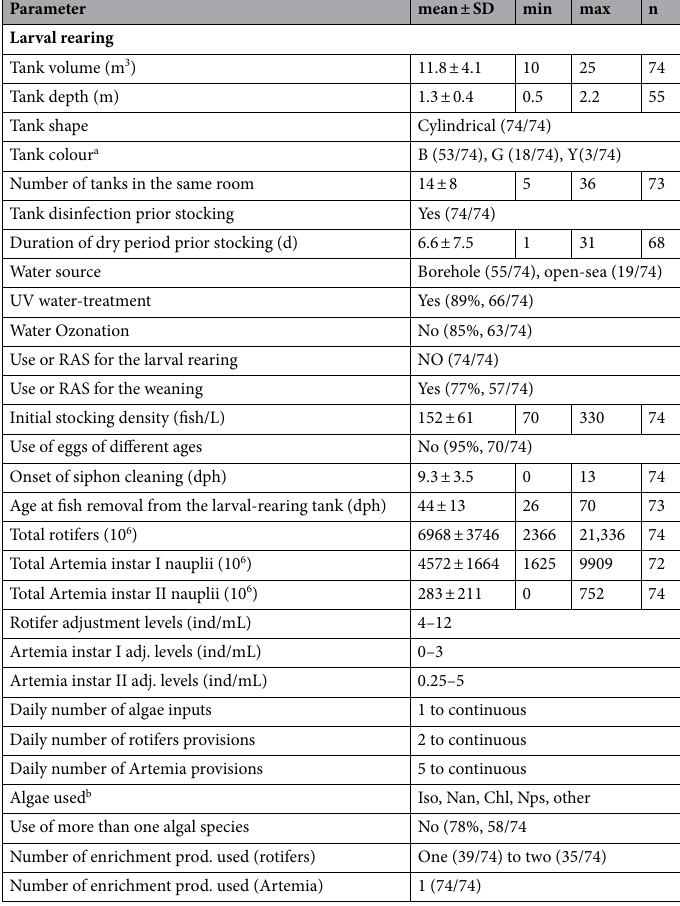
either in egg incubators (in 57% of the cases), or directly in the larval rearing tanks (in 43% of the cases). The mean reported rate of egg fertilization was 84.8 ± 4.9%. Table 1 summarizes all the rearing conditions which were monitored during the broodstock management and embryonic period. Larval rearing was performed in cylindrical tanks (10–25 m 3 volume, 0.5–2.2 m depth) with black, green or yellow walls (Table 2). Larval rearing was performed in flowthrough systems, with water pumped from boreholes or the open sea, and treated with UV and/or ozone. Mean water temperature gradually increased from 18.5 ± 0.4 °C at spawning, to 19.1 ± 1.0 °C at hatching and 21.4 ± 2.0 °C at 50 dph (Fig. 1A). Mean oxygen concentration was almost stable during the larval period (Fig. 1B), whereas mean pH decreased (Fig. 1C) and water exchange rate increased (Fig. 1D). Mean water salinity was generally stable during the studied period, with a short drop at ca 12 dph (Fig. 1E). Egg incubation and yolk-sac larval stage were performed in the dark, whereas at feeding onset a 16:8 to 24:0 h L:D photoperiod was applied (Fig. 1F,G). Larvae were reared at an initial stocking density of 152 ± 61 fish L −1 (Table 2) in the presence of background phytoplankton (3 ± 2 to 27 ± 12 dph, Fig. 2). According to the average feeding protocol which was applied, larvae were initially fed on enriched rotifers (4 ± 1 to 26 ± 9 dph), whereas in the next period Artemia instar I (14 ± 4 to 23 ± 5 dph) and enriched Artemia instar II nauplii (19 ± 4 to 41 ± 12 dph) were also provided. Weaning started on average at 32 ± 15 dph (Fig. 2). At 44 ± 13 dph fish were removed from the larval rearing tanks and transferred to weaning or pre-growing facilities. Further details on the larval rearing parameters are given in Table 2. The mean quantities of live and dry feeds provided to each larval population are given in Fig. S1. Key‑performance‑indicators. Fish size increased from 4.6 ± 0.7 mm TL at 12 dph to 16.7 ± 2.8 mm TL at 50 dph (Fig. 3A). At quality control (39 ± 6 dph) mean TL was 13.5 ± 2.6 mm (CV = 11.6 ± 2.2%, Fig. 3B) and SGR was 0.038 ± 0.003 d −1 . At the end of the larval rearing phase, the reported mean survival rate was 25.9 ± 21%,